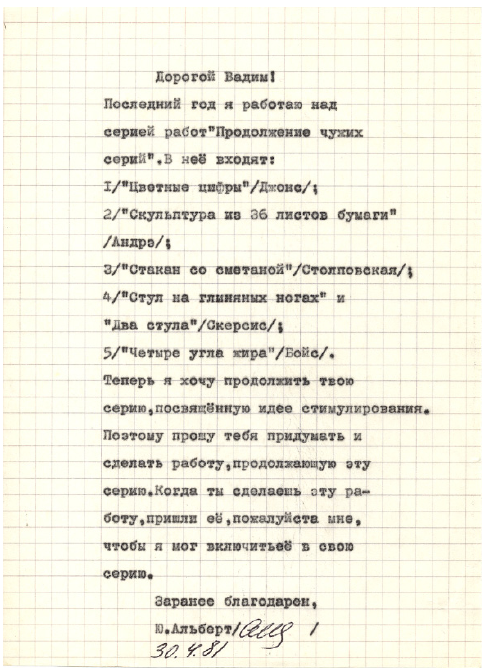
Figure 25. Albert. Letter to V. Zakharov (Continuation of the series “Stimulation”) . 1981. Paper, ink. Figure 25. Albert . Letter to V. Zakharov (Continuation of the series “Stimulation”). 1981. Paper, ink. 20.4 20.4 cm × 14.5 cm. Courtesy of the cm × 14.5 cm. Courtesy of the artist.